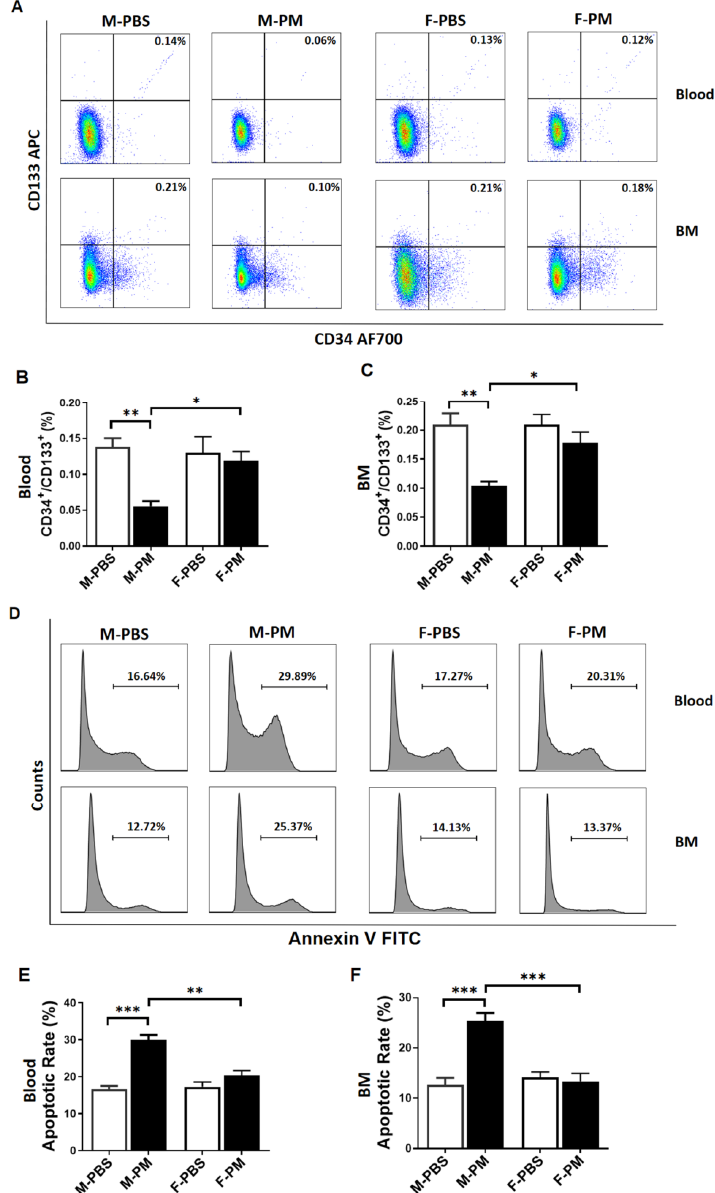
Figure 1. PM exposure selectively decreased EPC levels in blood and bone marrow with an in- creased apoptosis rate in male mice . ( A ) White blood cells were stained with CD133 APC and CD34 AF700 antibodies for flow-cytometric analysis of circulating ( upper panel) or bone marrow ( lower panel) EPCs (CD34 + /CD133 + ), with summary data ( B , C ) demonstrating that PM exposure selectively de- creased the EPCs populations in blood and bone marrow in male mice ( n = 6). ( D ) Cells’ apoptotic rates of EPCs in blood and bone marrow as determined by flow cytometry analysis of Annexin V-FITC stained cells, with summary data for EPCs in blood ( E ) and in bone marrow ( F ) showing that PM exposure selectively increased EPCs apoptotic rates in male, but not in female, mice ( n = 6). M-PBS: male mice with PBS treatment; M-PM: male mice with PM exposure; F-PBS: female mice with PBS treatment; F-PM: female mice with PM exposure. BM: bone marrow. * p < 0.05, ** p < 0.01 and *** p <